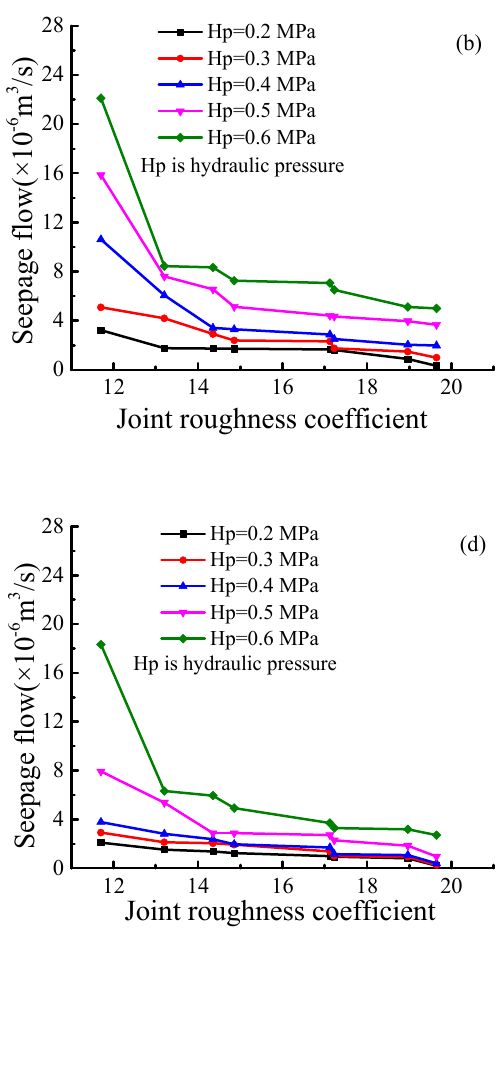
Figure 6. Relationship between joint roughness coefficient and seepage flow under different normal pressure and water pressure values. ( a ) Normal stress = 0.10 MPa, ( b ) Normal stress = 0.15 MPa, ( c )